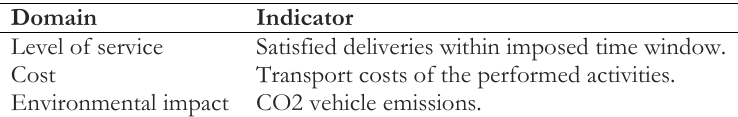
Table 3. Key assumptions for last-mile GIS & vehicle routing analysis.